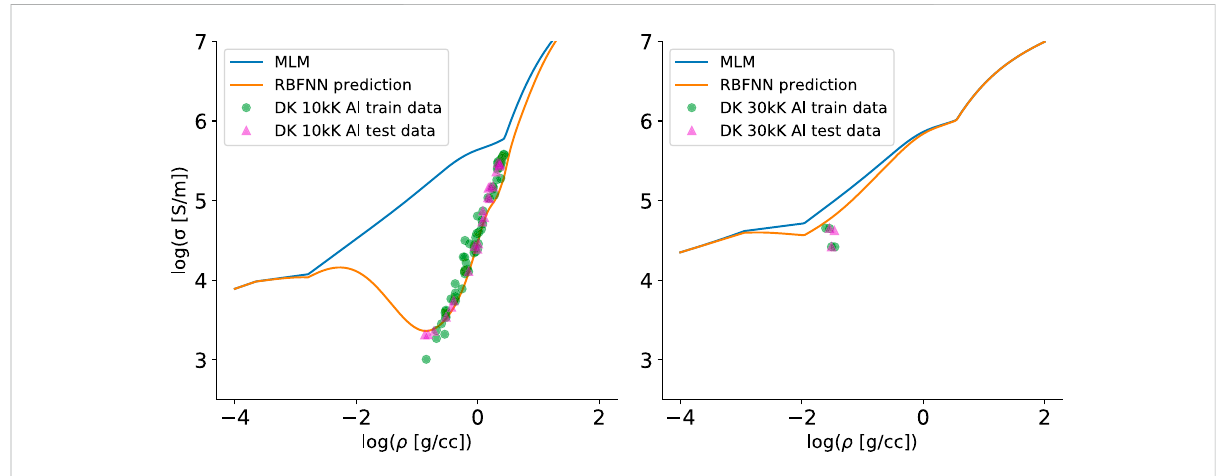
FIGURE 9 ClusteringoftheDKAldata.AsinFigure2,colorsrepresentsilhouettescores;darkerpointsarelesswellclustered.Notethatclustersareformed using all three dimensions (with Z fi xed). Five clusters are used, which is two greater than the silhouette score suggested; this increase in cluster number gave an improved prediction.